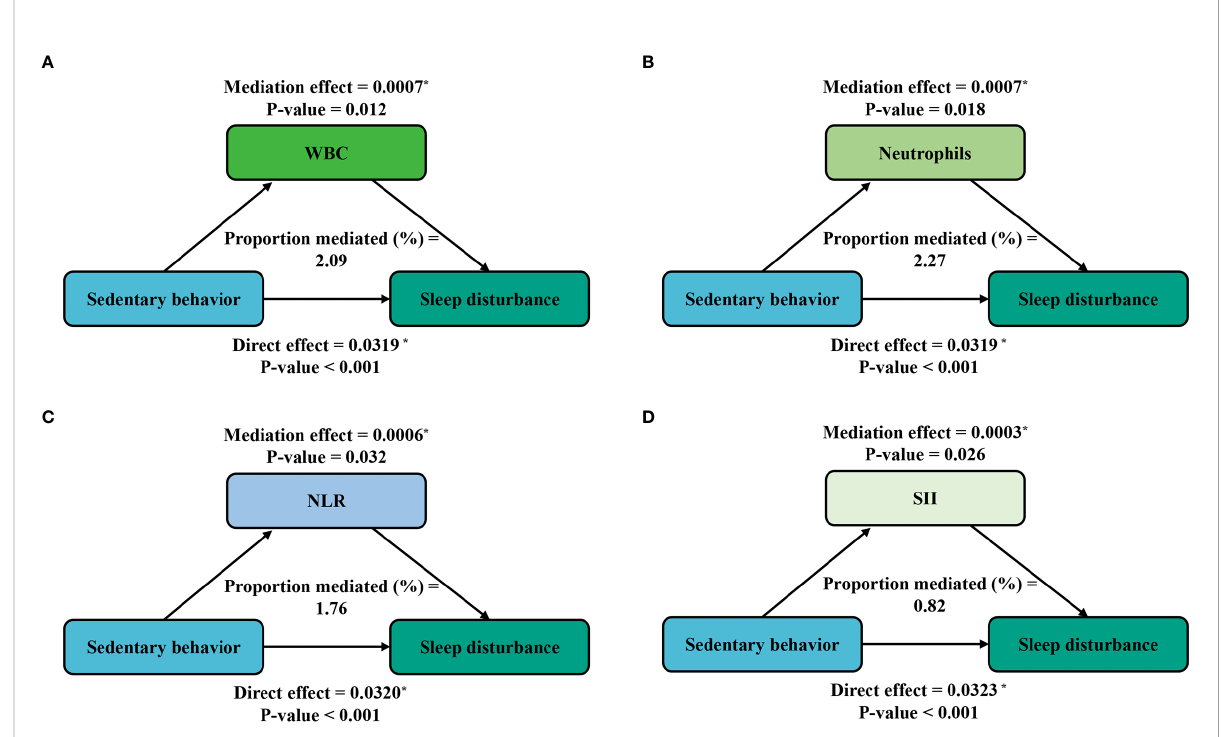
FIGURE 3 Path diagram of the mediation analysis of in fl ammatory biomarkers on the relationship between sedentary behavior and sleep disturbance. The graphs in (A – D) represented the mediating role of WBC, neutrophils, NLR, and SII,